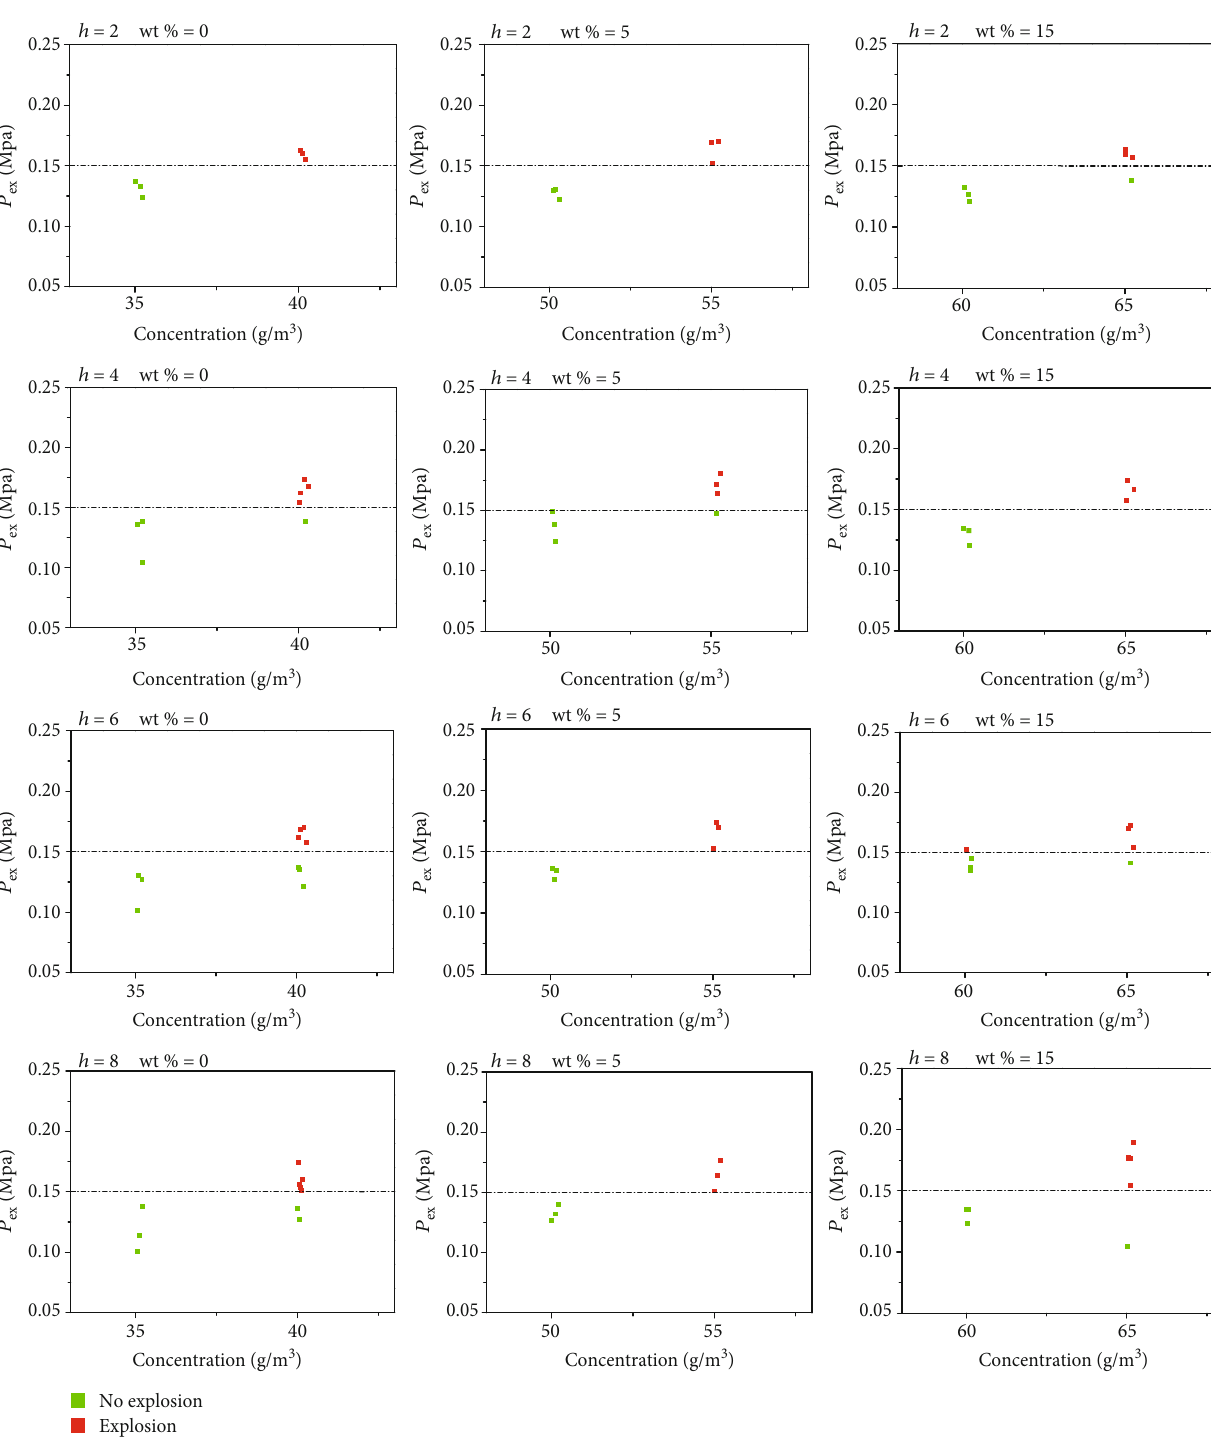
Figure 7: Maximum explosion pressures of aluminum powders with di ff erent moisture contents as oxidized for 2 h, 4h, 6h, and